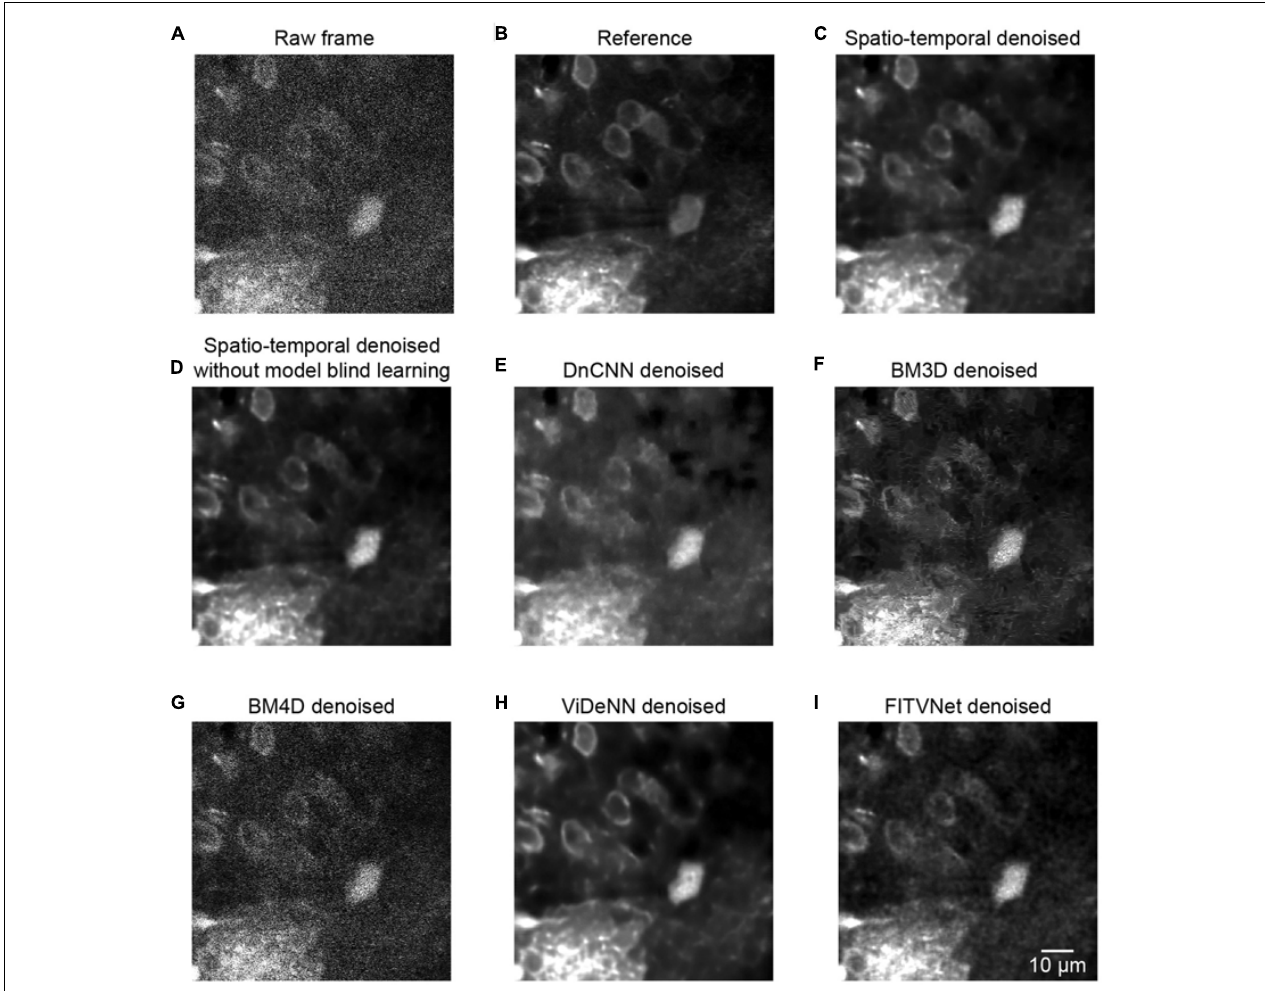
FIGURE 7 | Comparison of denoising performance for seven methods. (A) A single raw frame of the two-photon imaging data. (B) The ground truth reference. Restored images using (C) the proposed model blind spatiotemporal filtering method, (D) spatiotemporal filtering network without model blind learning, (E) DnCNN method, (F) BM3D method, (G) BM4D method, (H) ViDeNN method, and (I) FITVNet